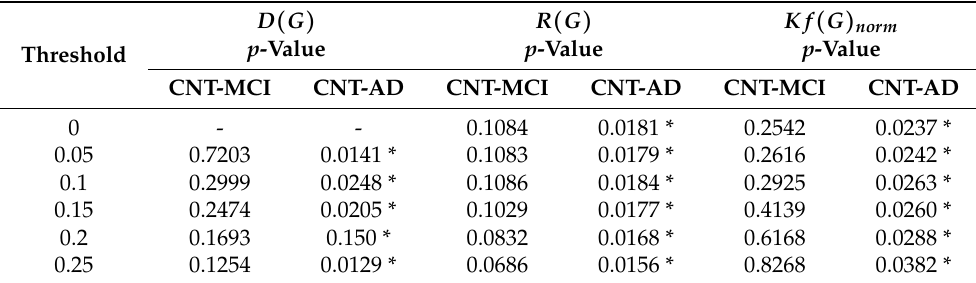
Table 4. p -values resulting from the Wilcoxon rank sum test.